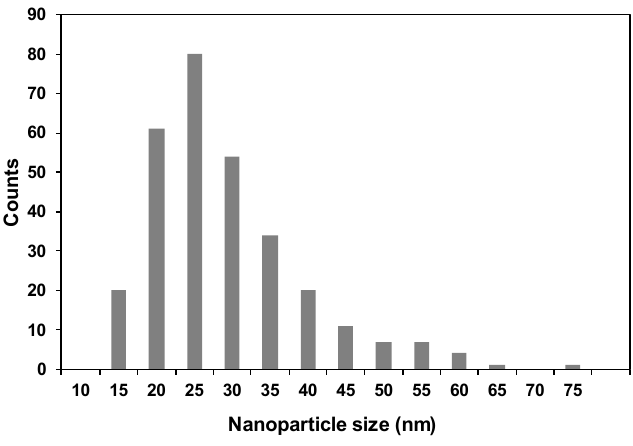
Figure 2. Particle size distribution histogram of TiO 2 NP.